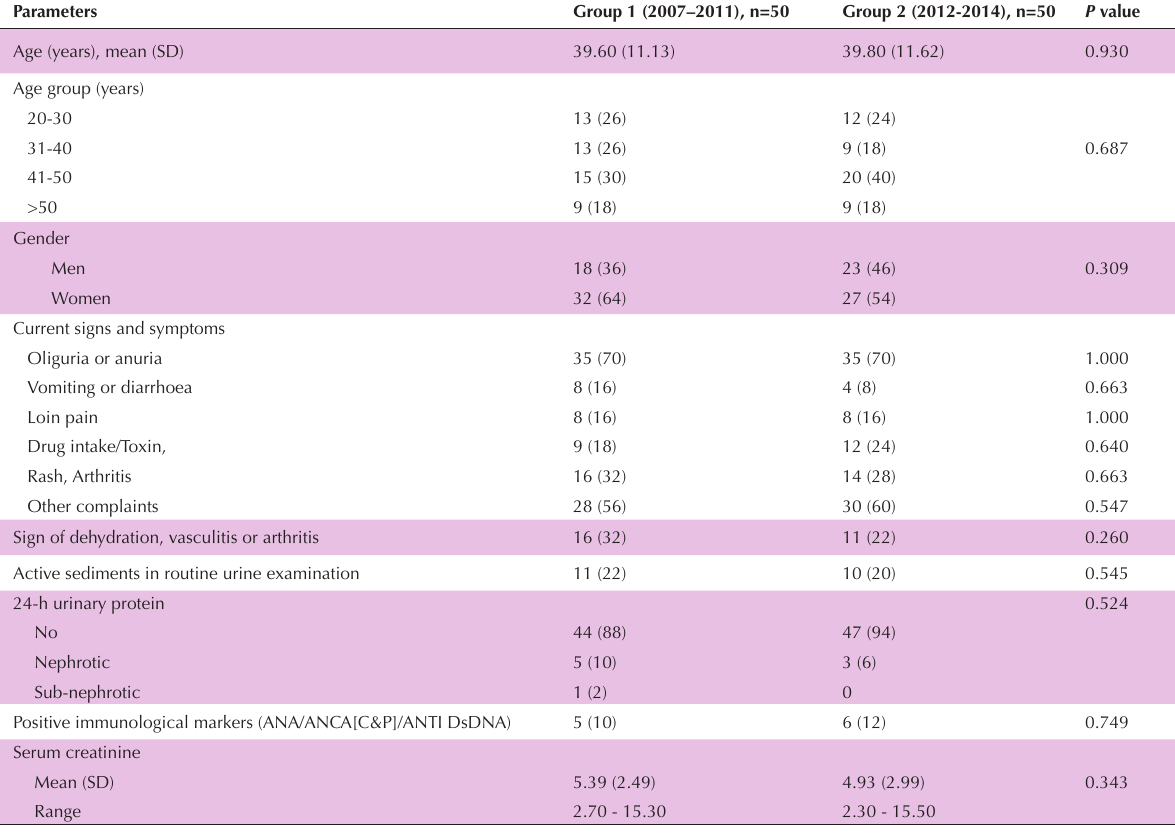
Table 1. Patient demographics and clinical characteristics